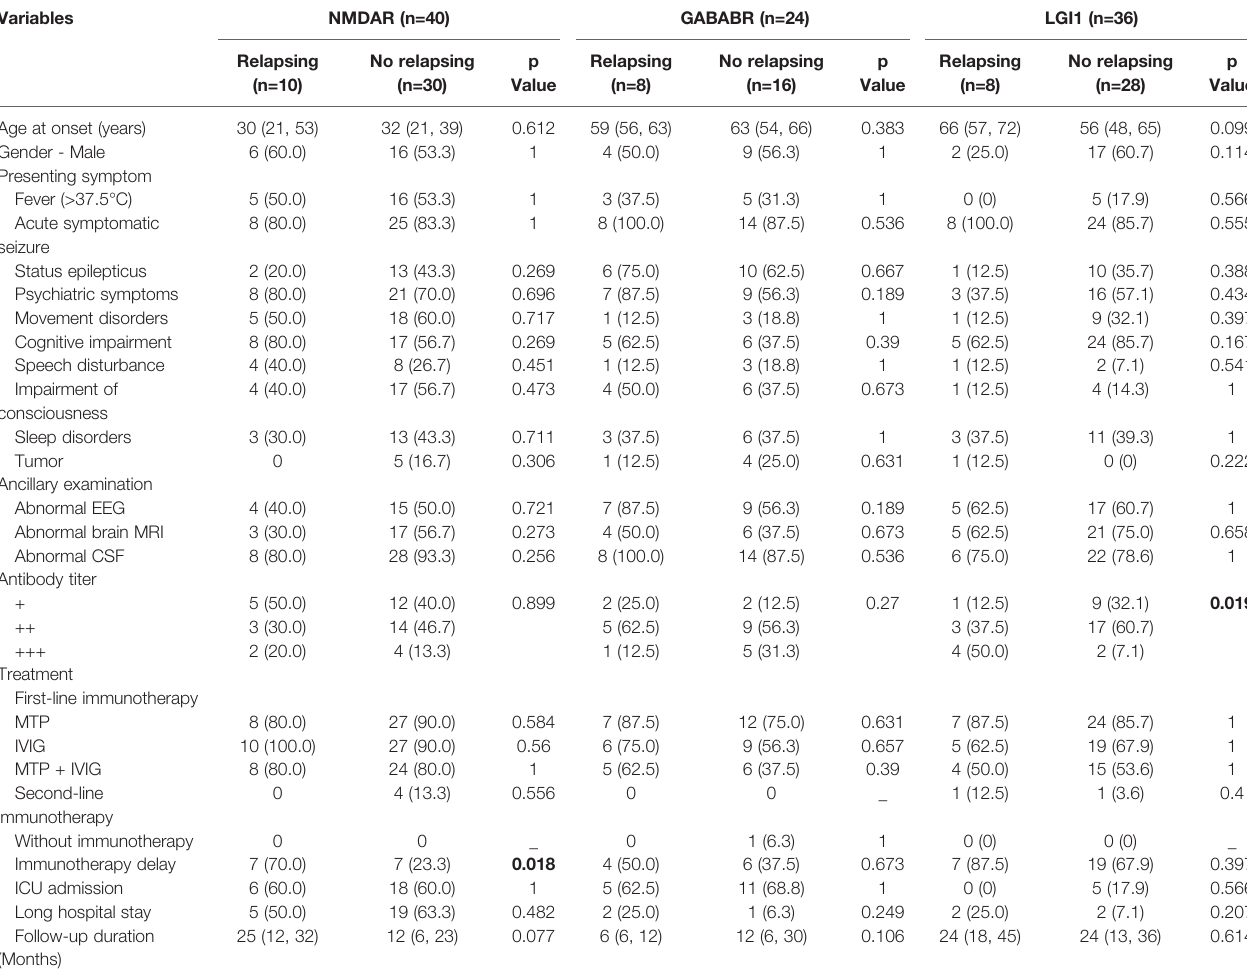
TABLE 3 | Univariate analysis of variables associated with relapse in anti-NMDAR, anti-GABABR and anti-LGI1 encephalitis, respectively.